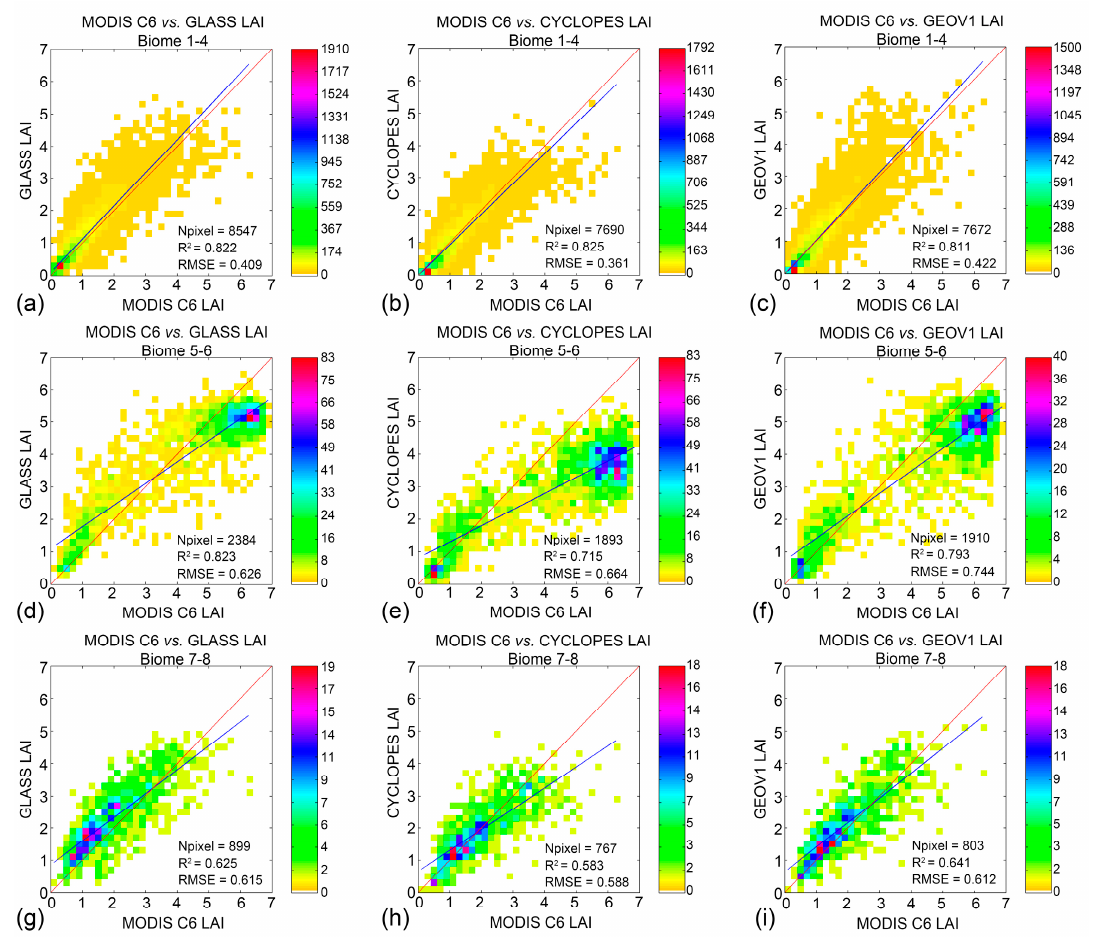
Figure 6. Density scatter plots of monthly MODIS LAI and three other LAI products (left: GLASS; middle: CYCLOPES; right: GEOV1) over BELMANIP sites during the time period from 2001–2005. The plots show a correlation between MODIS and other products for non-forest (( a – c ) Biomes 1–4) in the first row, broadleaf forests (( d – f ) Biomes 5 and 6) in the second row and needle leaf forests (( g – i ) Biomes 7 and 8) in the third row. The red lines and blue lines are the 1:1 lines and regression lines derived from the scatter plots, respectively.